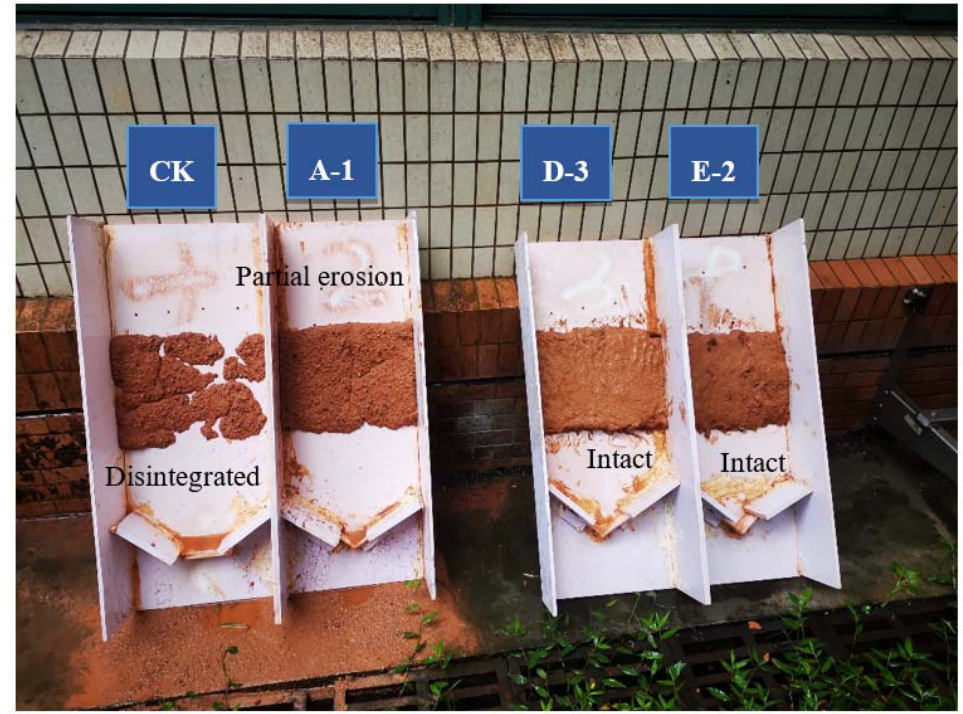
Figure 8. Condition of the typical simulated slope after 15 min